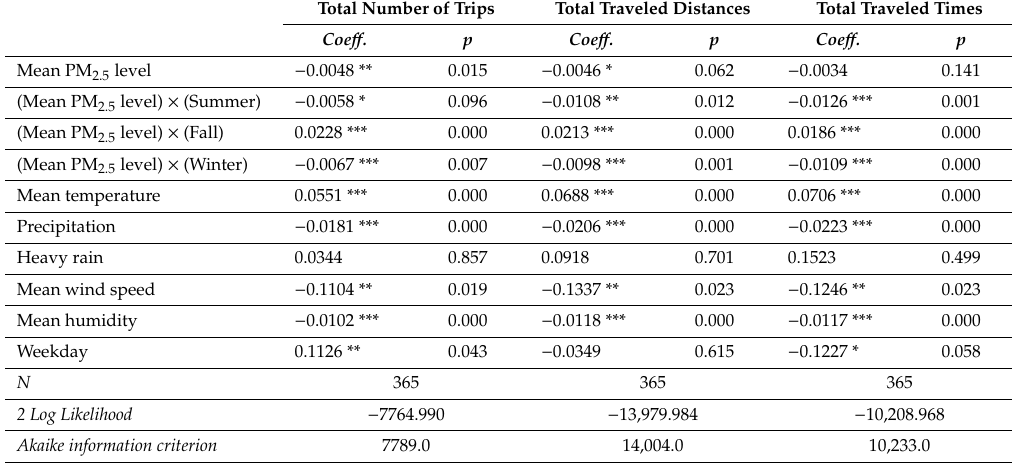
Table A2. Estimation results for bike sharing using multiplicative interaction variables for seasons and PM 2.5 level